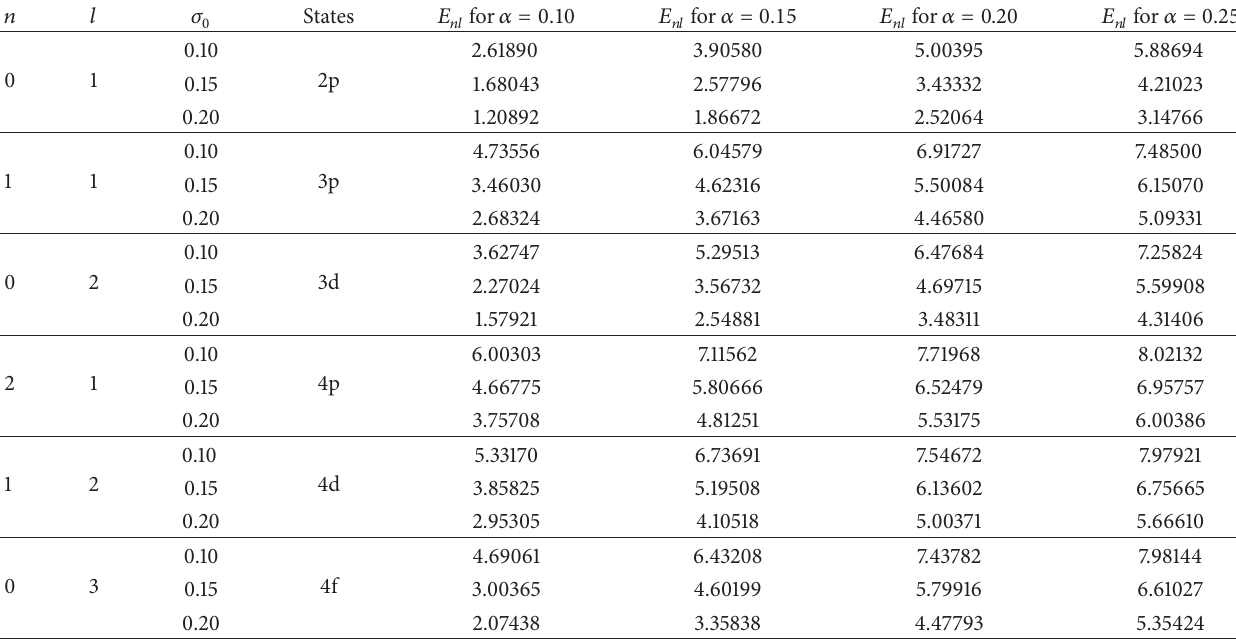
Table 3: Nonrelativistic energies at the poles of 𝑠 -matrix (in units fm −1 ) for the hyperbolical potential as a function of positive potential